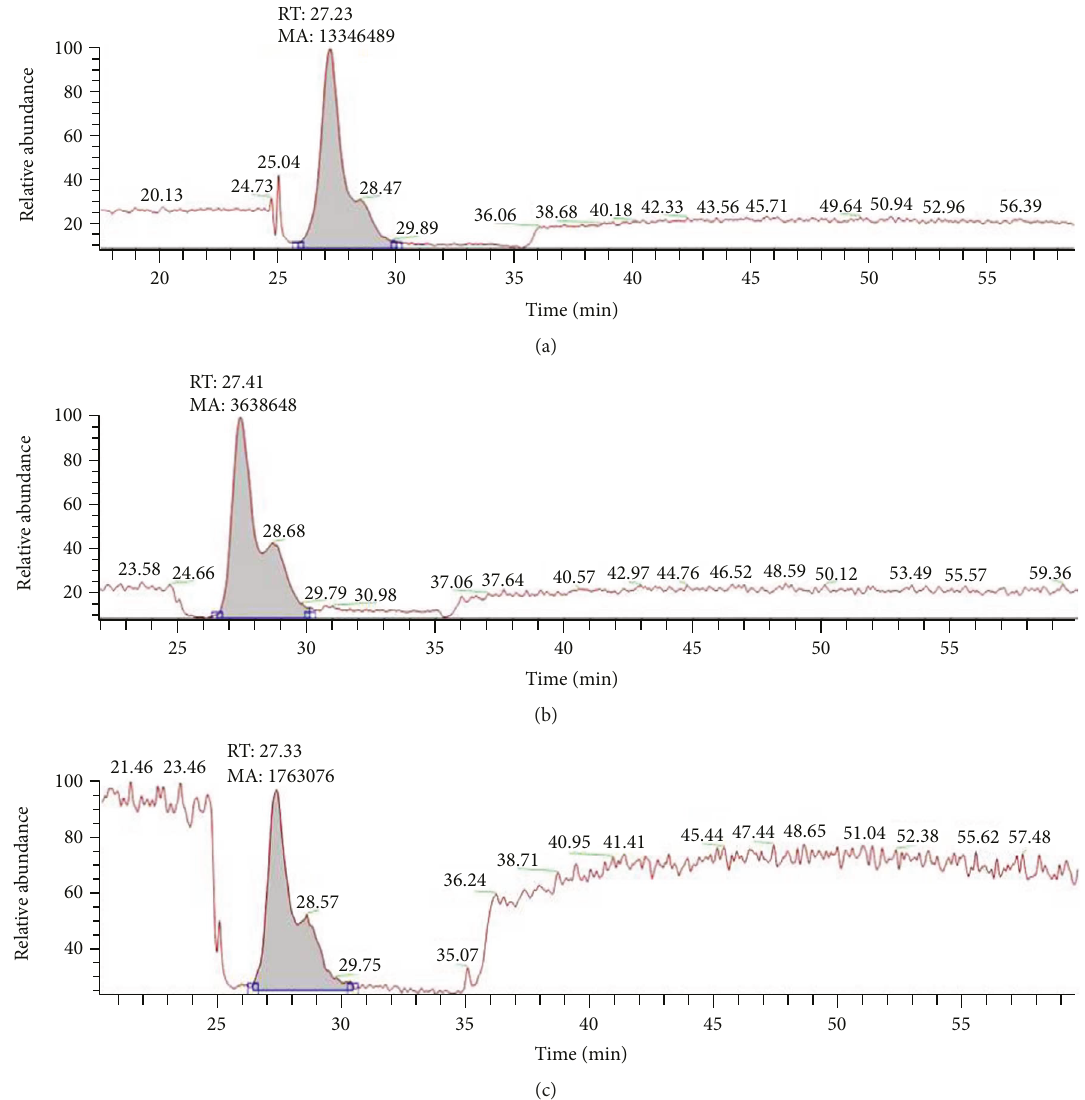
Figure 4: HPLC-MS of 3-MC in Huaihe River Basin water samples. (a) River water; (b) well water from 10-meter depth; and (c) well water from 40-meter